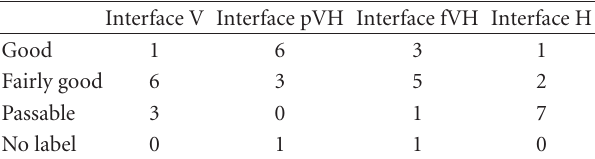
Table 3: Answer incidences for spontaneous remarks. Table 4: Answer incidences for experienced